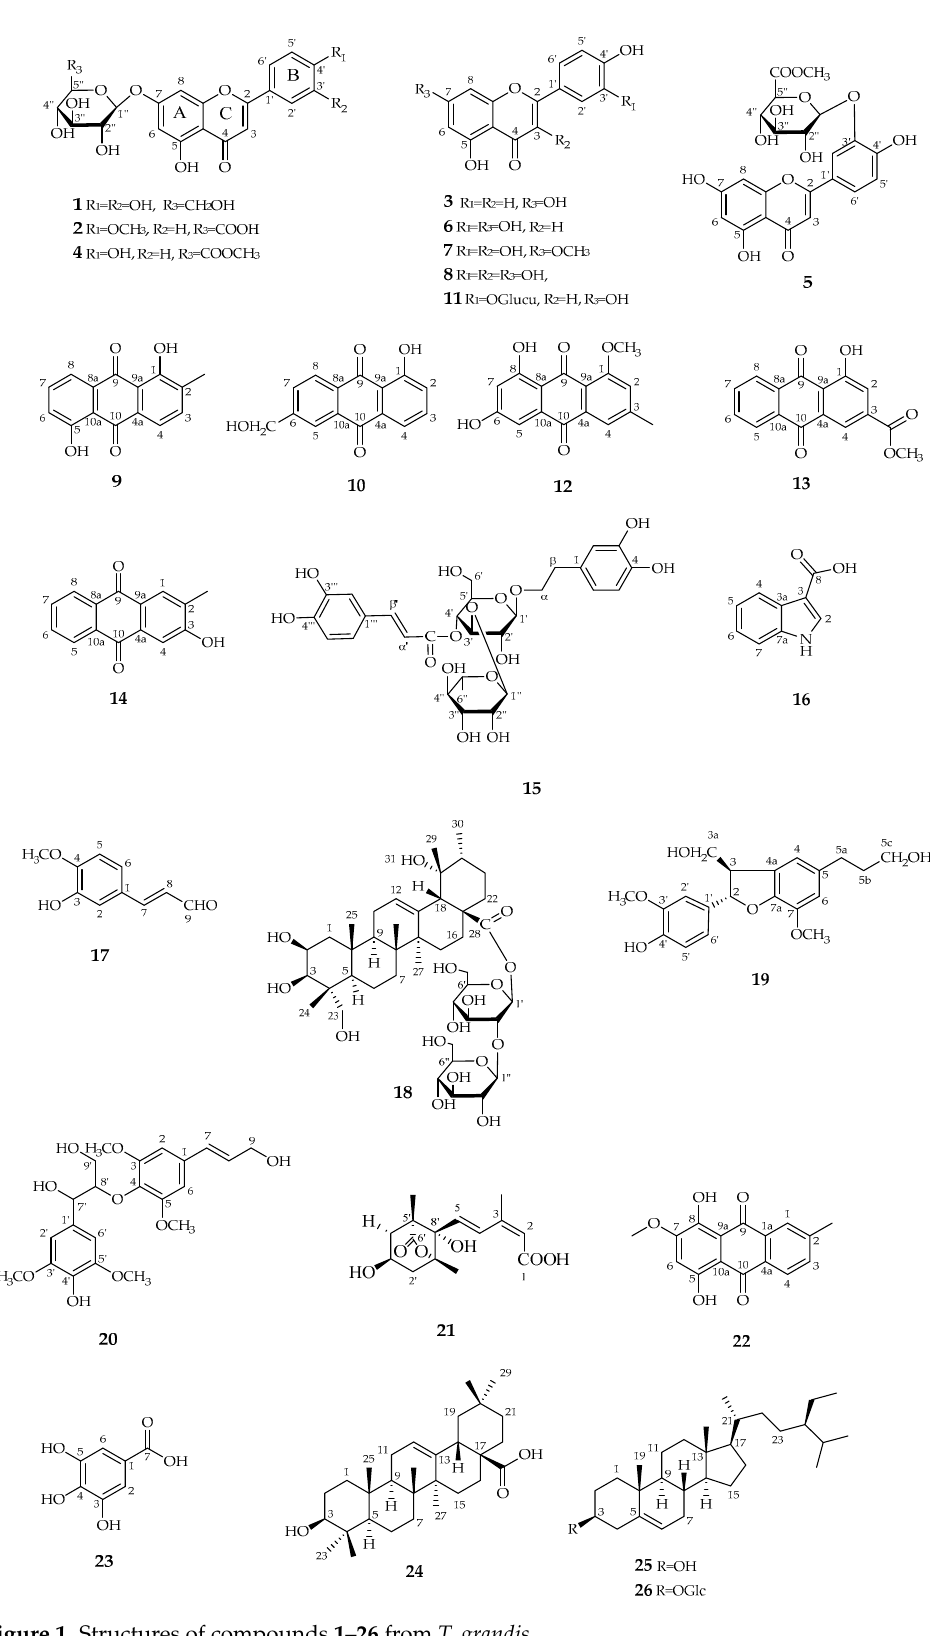
Figure 1. Structures of compounds 1 – 26 from T. grandis .